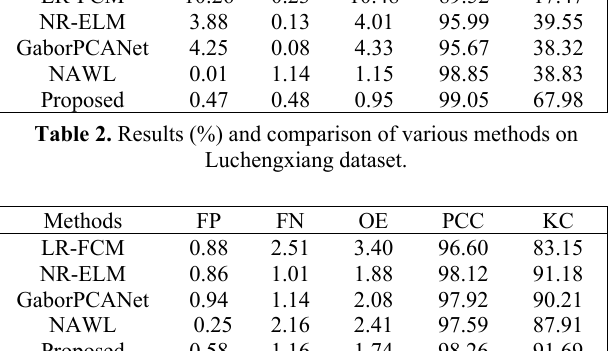
Figure 6. Results of Yamenkou dataset: (a) LR-FCM. (b) NR- ELM. (c) GarborPCANet. (d) NAWL. (e) Proposed. (f) Reference image.